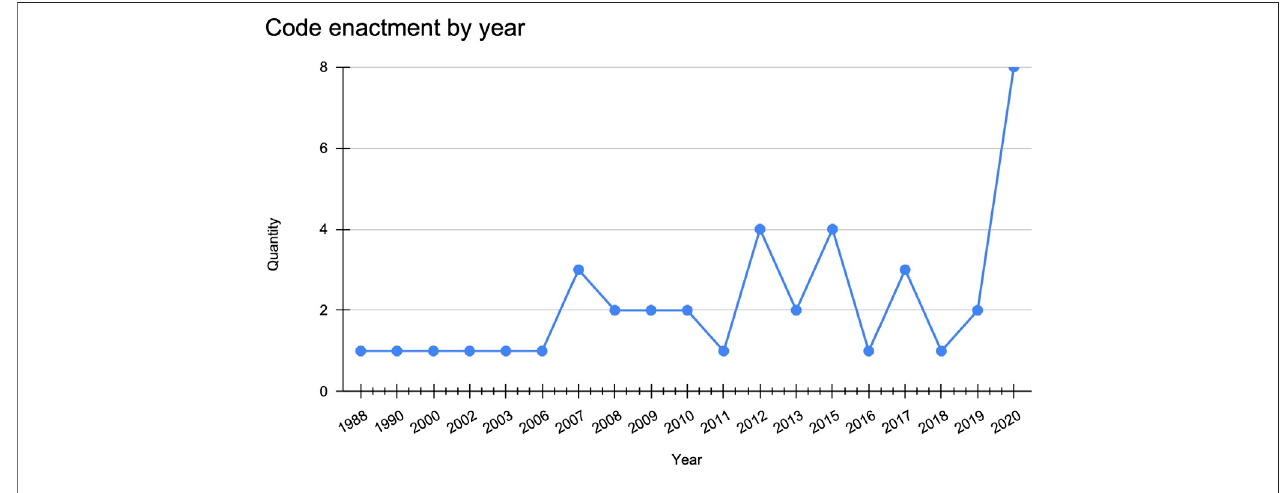
FIGURE 1 | Tribal public health code enactment by year ( N (cid:1)